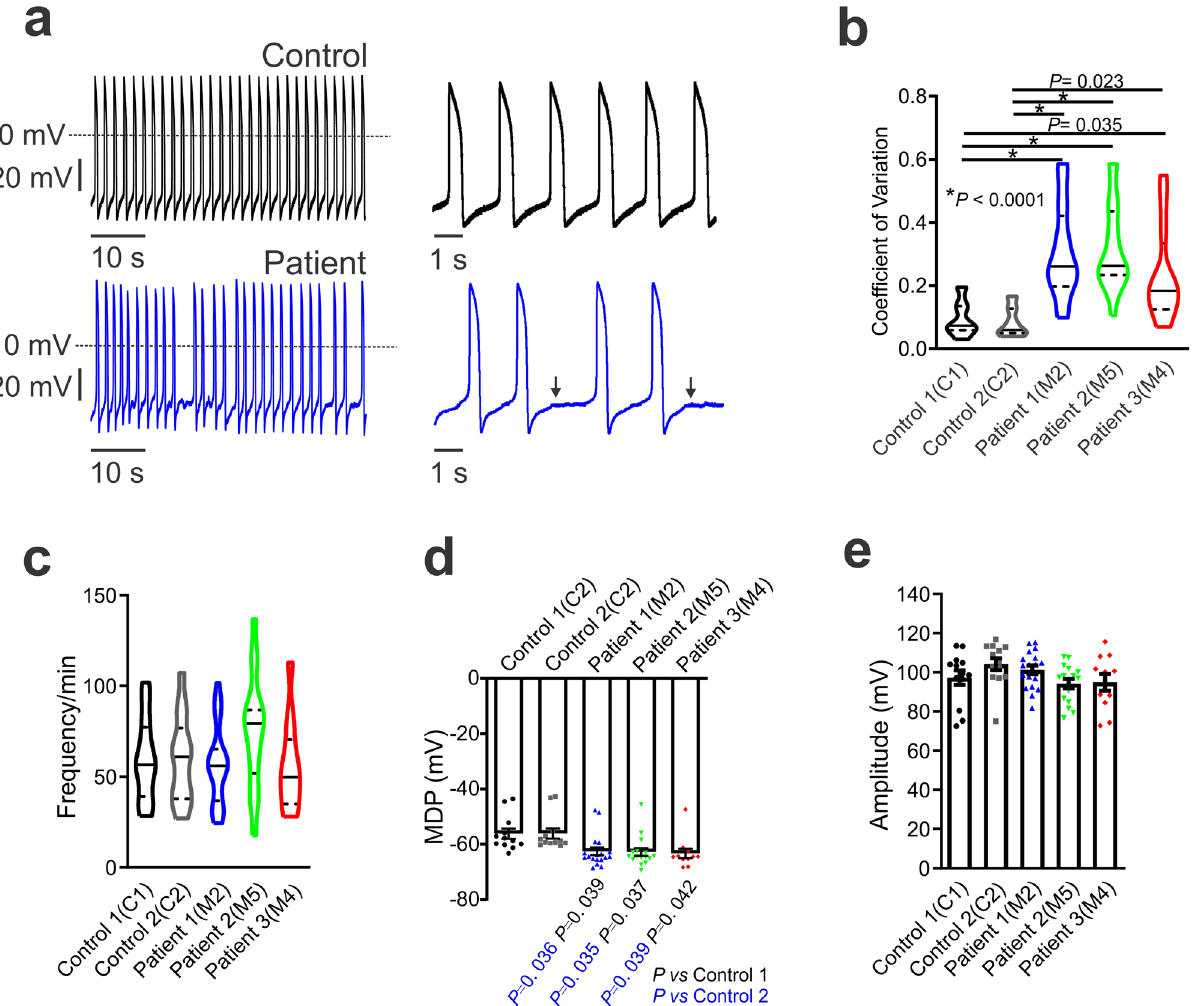
Fig. 6 Pacemaker stability is disrupted in CAID-patient hiPSC-CMs. a Spontaneous action-potential recordings from control (C1, black) and patient (M2, blue) single hiPSC-CMs. The short vertical lines at left are 20 mV scales. b Analysis of coef fi cient of variation of action potential fi ring in healthy control and CAID patient-speci fi c hiPSC-CMs. n C1 = 14, n C2 = 13, n M2 = 24, n M5 = 19, and n M4 = 12 biologically independent cells. Data are represented as violin plots, with median (solid line) and interquartile range (dotted line). One-way ANOVA with Tukey ’ s multiple comparison test. c Spontaneous action potential frequency in control and CAID-patient hiPSC-CMs. n C1 = 14, n C2 = 13, n M2 = 24, n M5 = 19, and n M4 = 12 biologically independent cells. Data are represented as violin plots, with median (solid line) and interquartile range (dotted line). There was one cell without meaningful action potentials in control 1 (C1), one cell in patient 1 (M2) and 1 cell in patient 2 (M5); these were not analyzable for frequency and were not included in analyses. d MDP in control and CAID-patient hiPSC-CMs. n C1 = 12, n C2 = 12, n M2 = 18, n M5 = 16, and n M4 = 11 biologically independent cells. Data are expressed as mean ± SEM. One- way ANOVA with Tukey ’ s multiple comparison test. e Action potential amplitude in control and patient hiPSC-CMs. n C1 = 12, n C2 = 15, n M2 = 18, n M5 = 16, and n M4 = 11 biologically independent cells. Data are expressed as mean ±